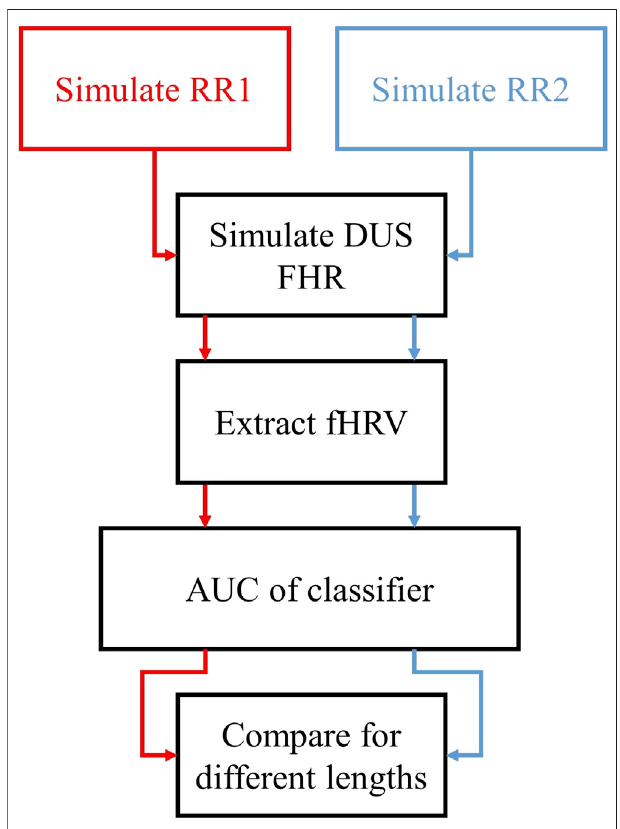
FIGURE 4 | Outline of the assessment of the discriminability of fHRV features as functions of the AC window length. We simulated two sets of FHR RRI sequences with different PSD and ApEn distributions. Then, we extractedthe fHRV ofthe simulated FHR DUS for each case, and